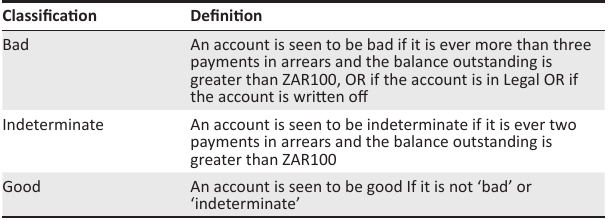
TABLE 4: Internal application scorecard ‘Bad’ definition. Classification